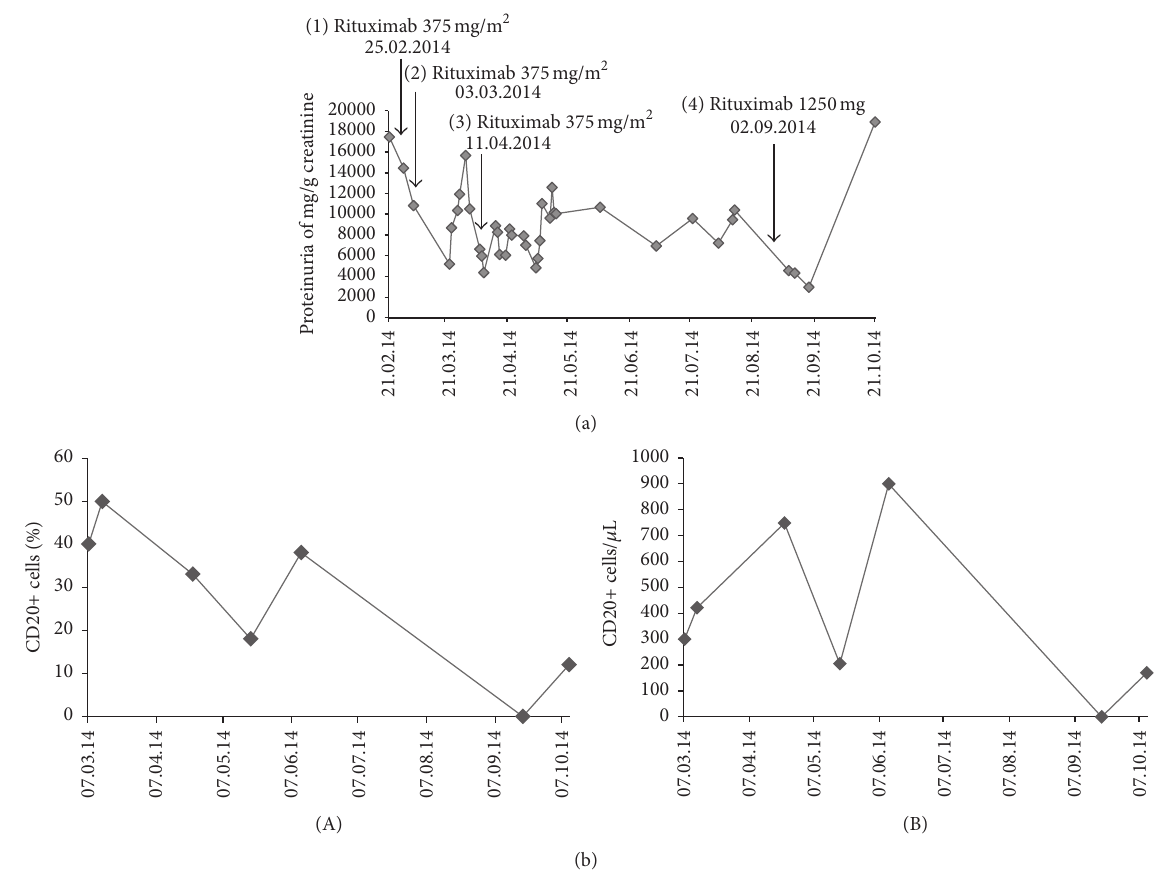
Figure 1: Kinetic of proteinuria (a) and CD20 cell count (b) in the first case. CD20 cell count is both displayed as absolute values (A) as well as percentage (B). Time points of Rituximab administrations are marked